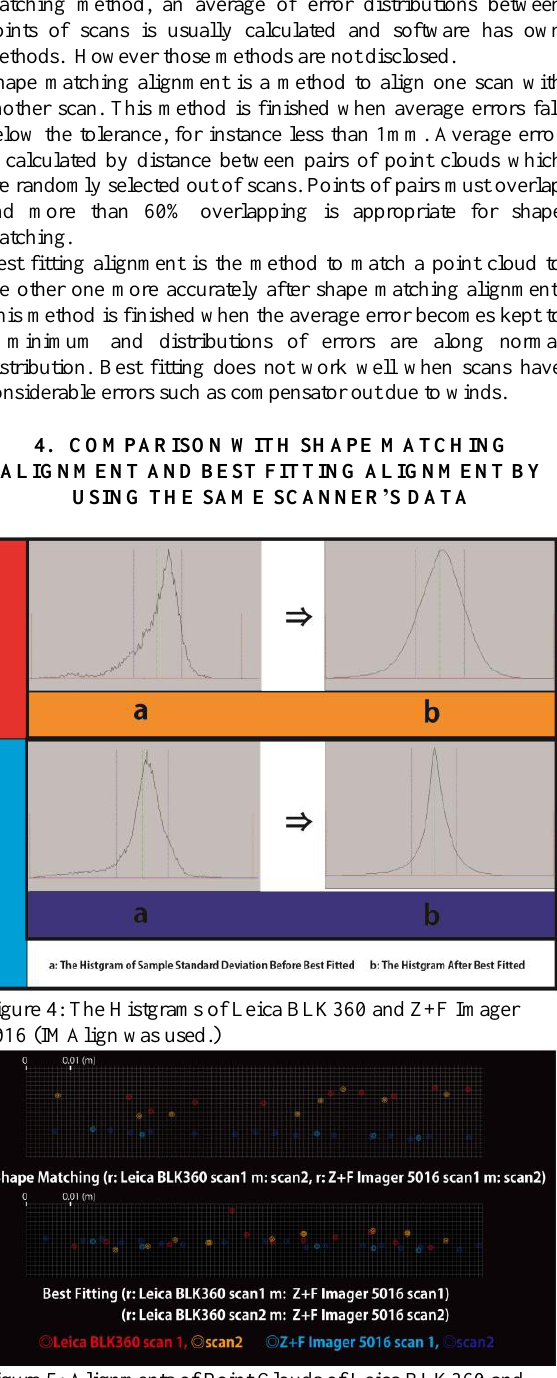
Figure 5: Alignments of Point Clouds of Leica BLK360 and Z+F Imager